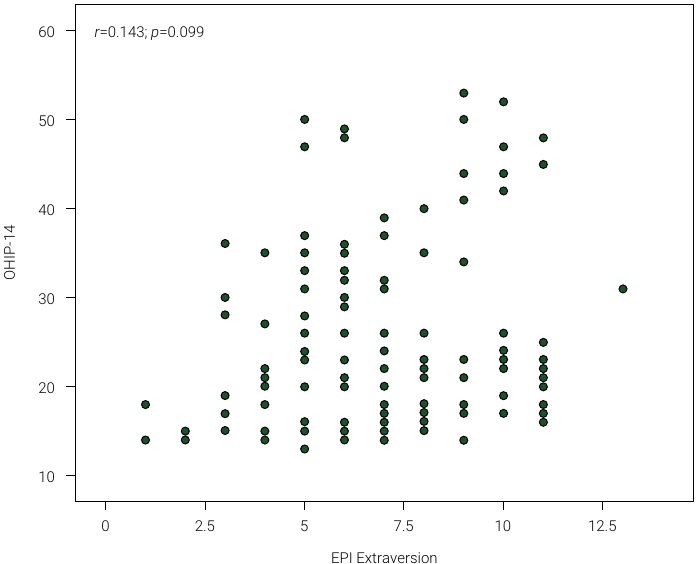
Figure 7. Ratio between Extraversion and OHIP-14 test results (r=0.143; p